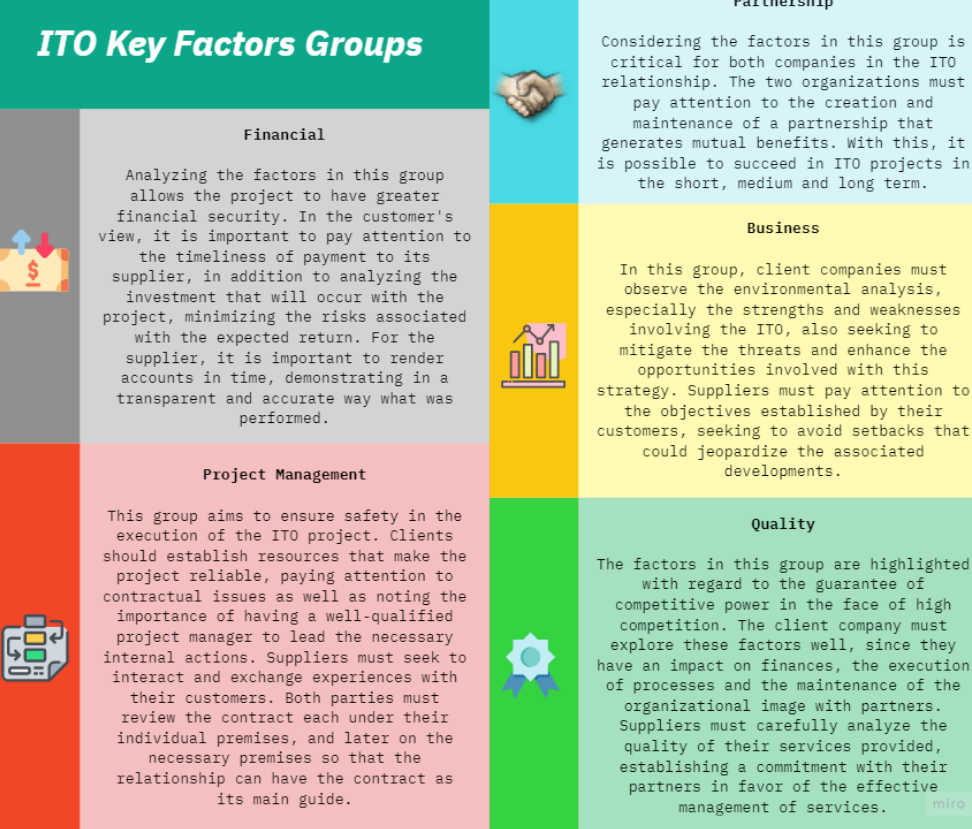
Figure 5. Infographic on the factor